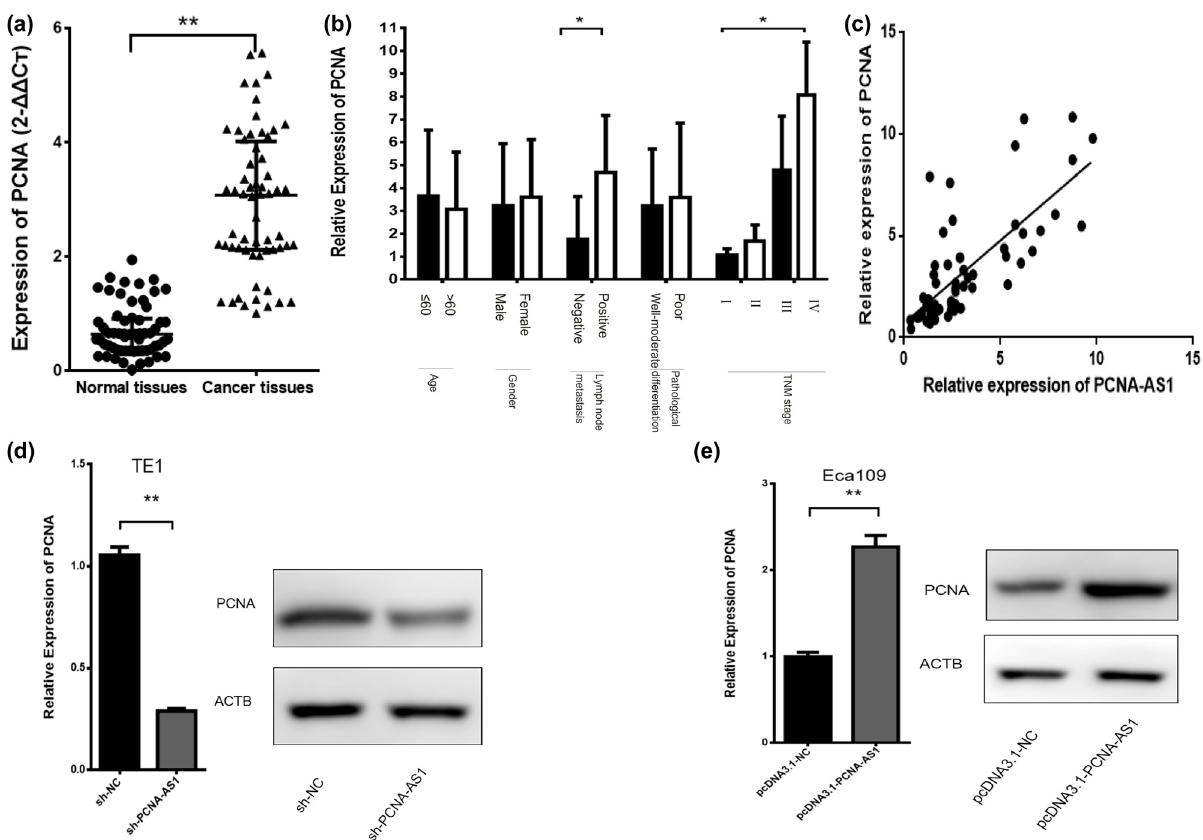
Figure 3: PCNA acts as an oncogene in ESCC and is regulated by PCNA - AS1. ( a ) The expression of PCNA in 60 pairs of ESCC tissues and normal tissues by the qRT - PCR assay. ( b ) The relationship between PCNA expression and the clinicopathological characteristics of ESCC patients. ( c ) The relationship between PCNA - AS1 and PCNA in ESCC ( r 2 = 0.552, P < 0.01 ) . ( d ) Knockdown of PCNA - AS1 signi fi cantly suppressed PCNA expression levels in TE1 cells. ( e ) Overexpression of PCNA - AS1 signi fi cantly promoted PCNA expression levels in Eca109 cells. *P < 0.05 and **P <